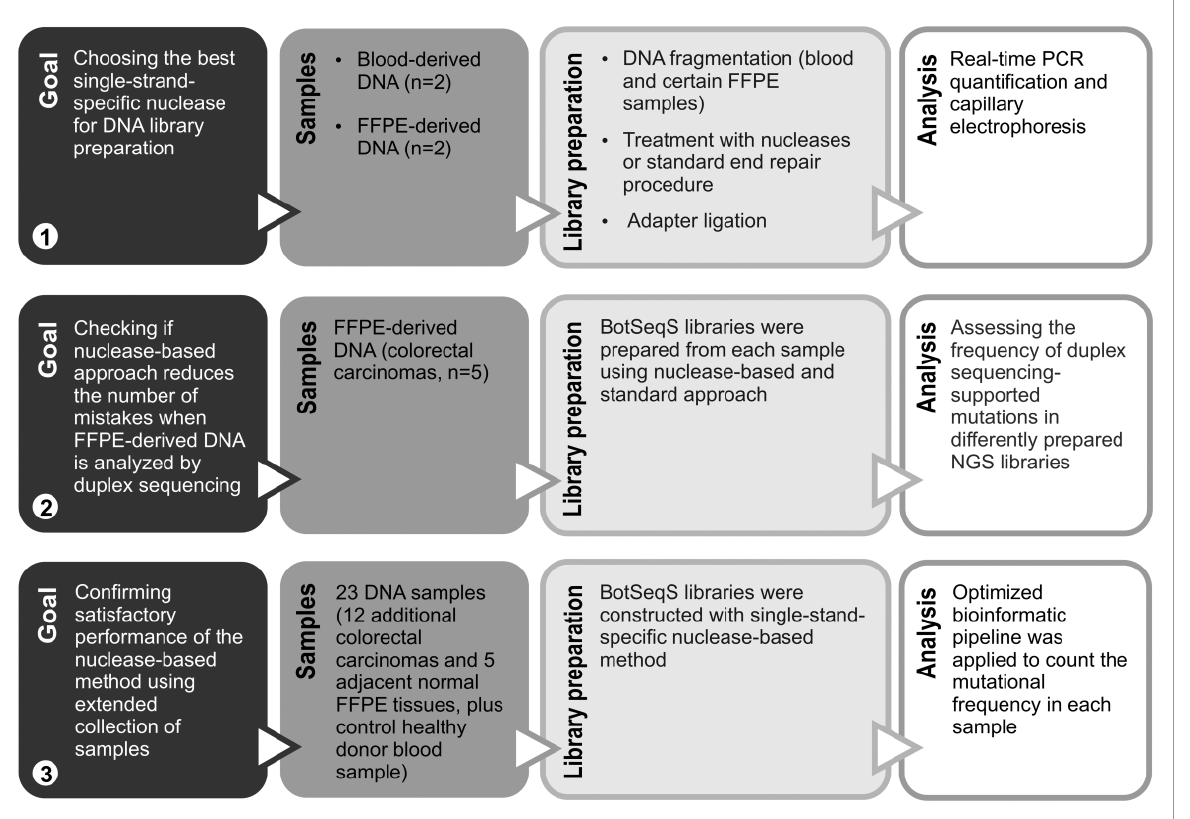
Figure 1. General overview of the experiments described in the article.